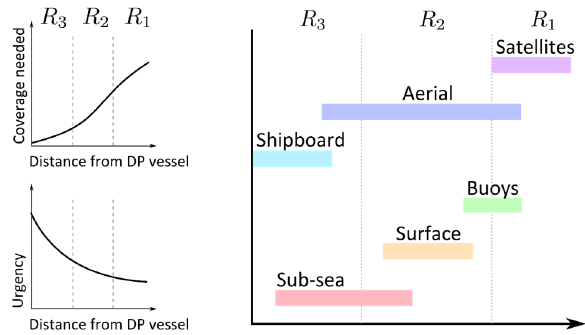
Figure 17: Illustration of coverage achieved by differ- ent sensor platforms. R 1 to R 3 are ice ob- servation regions of interest, ranked largest to smallest area. Courtesy: Joakim